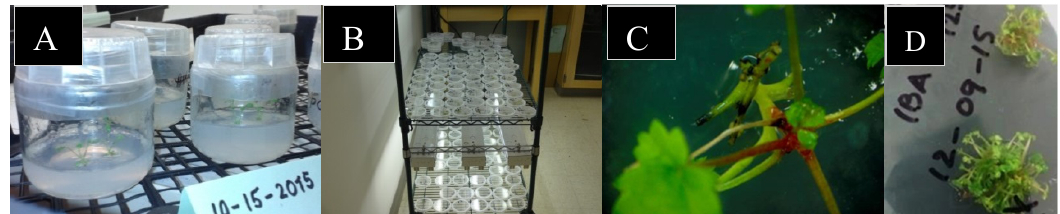
Figure 1. ( A ) Transfer of seedlings cv. Baron Solemacher to bottles with MS medium. ( B ) Setup of experiment. ( C ) Baron Solemacher single axillary bud shoot explants producing new shoots. ( D ) Baron Solemacher with single axillary bud shoot explants produced the maximum number of shoots at BA 2.00 (mg L − 1 ) + IBA 0.125 (mg L − 1 ).